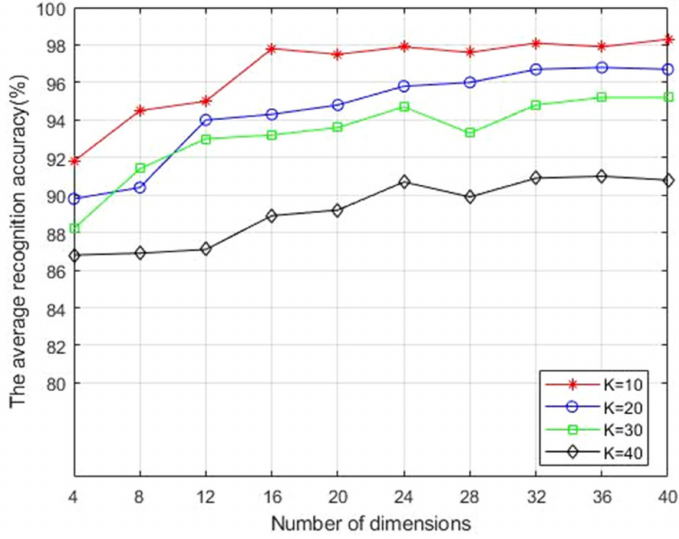
Figure 3. Average recognition accuracy (%) of the 2DESDLPP algorithm corresponding to different K values with feature dimensions when the training sample in the Yale database is